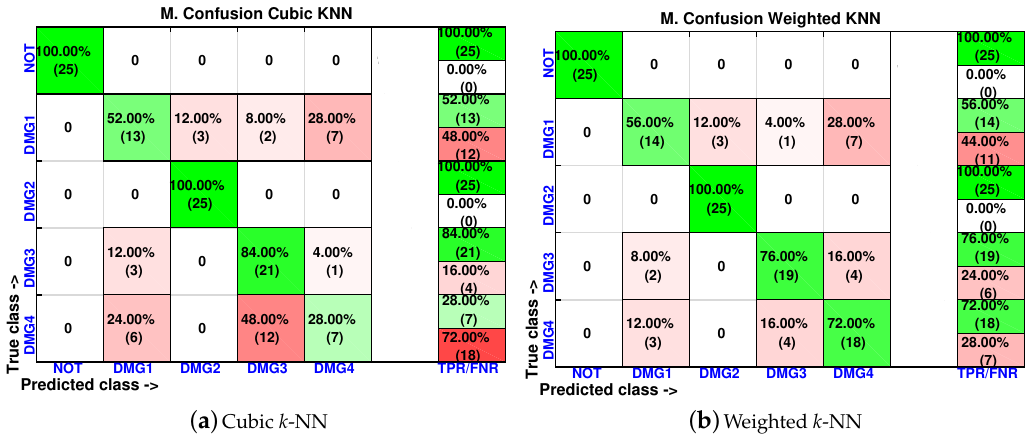
Figure 17. Confusion matrix using cubic k -NN and weighted k -NN when the feature vector is formed by the first principal component.